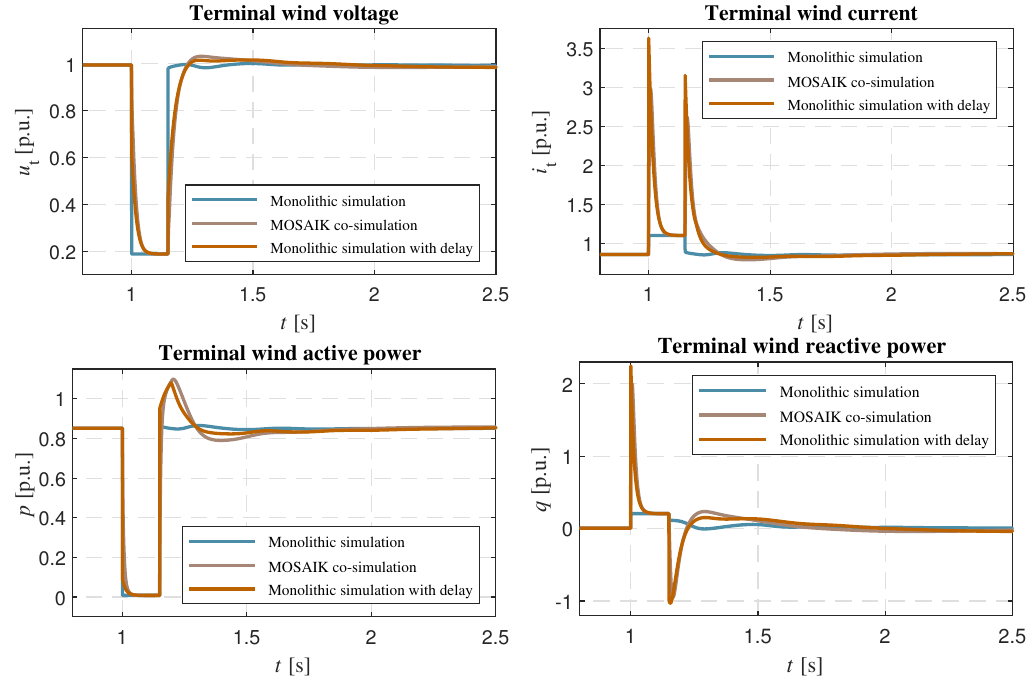
Figure 19. Dynamic short-circuit response of the wind turbine considering a delay of 10 ms in the controls within the monolithic simulation